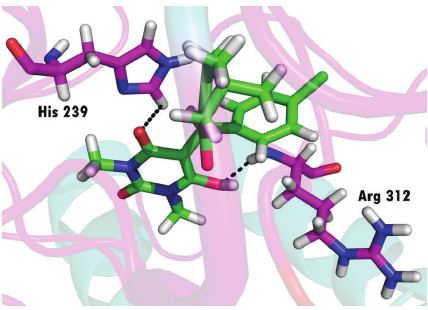
Figure 4: Three-dimensional representation of compound 4p with target macromolecule 𝛼 -glucosidase.